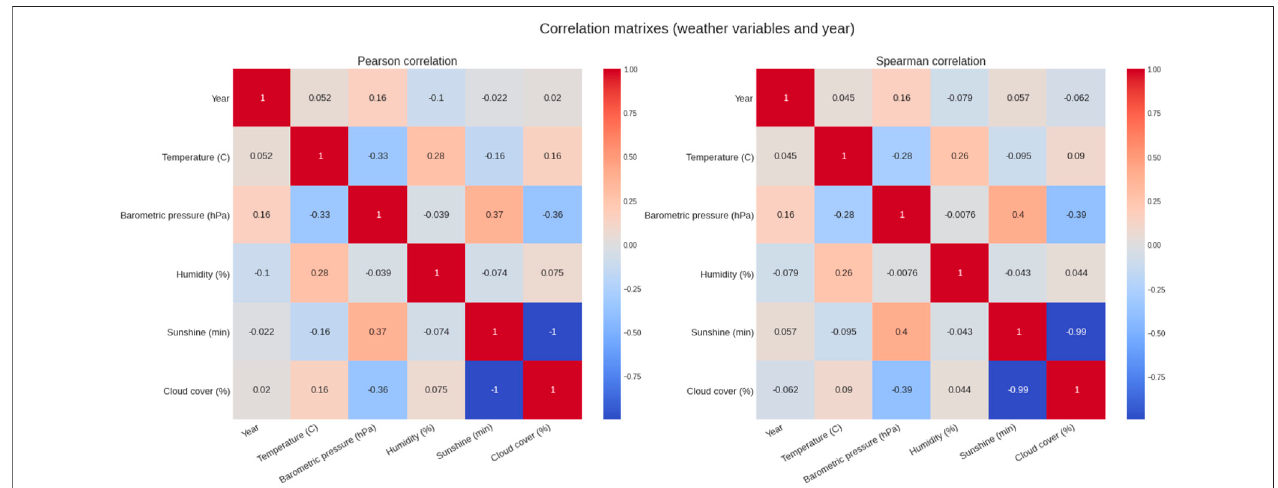
FIGURE 6 | Correlation matrixes for weather variables and year.